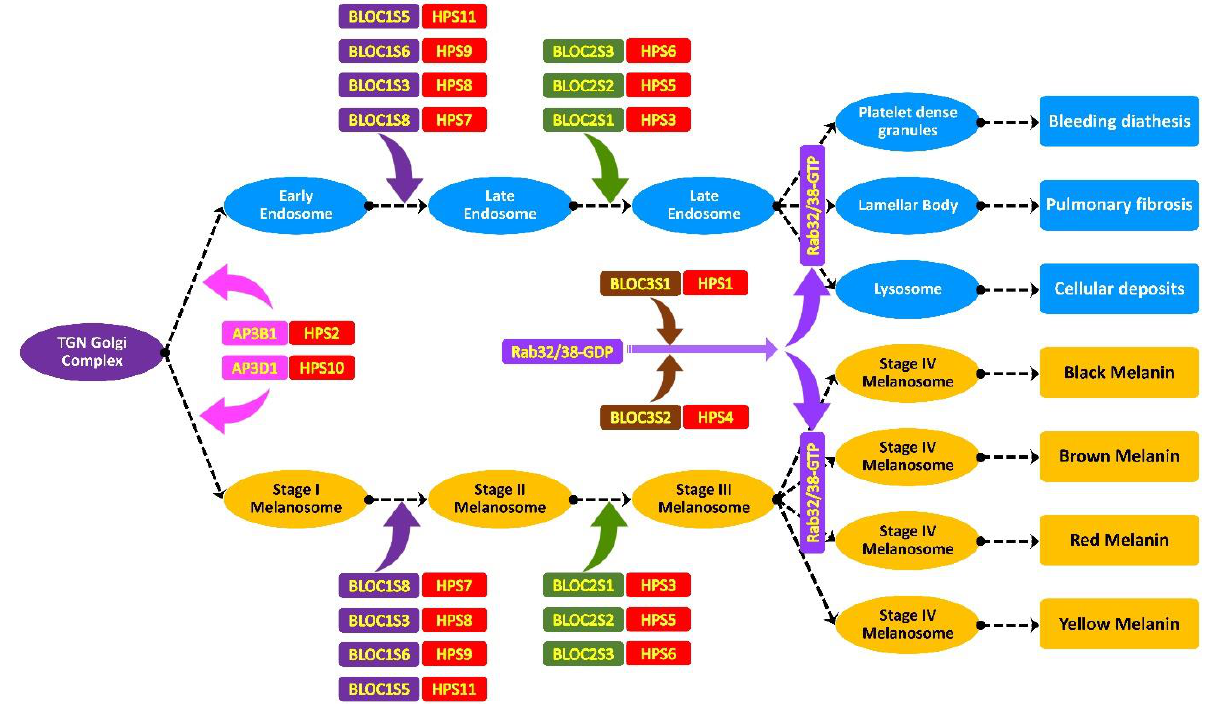
Figure 5. Endosomal pathway of TGN (trans-Golgi network) showing different stages of melanosome maturation, platelet δ -granule (dense granule), lamellar body and lysosome formation are shown. Protein complexes AP-3 (adaptor protein), BLOC-1 (biogenesis of lysosome-related organelles complex-1), BLOC-2 (biogenesis of lysosome-related organelles complex-2) and BLOC-3 (biogenesis of lysosome-related organelles complex-3) are shown. Any mutation in these complexes or in their subunits result in a different class of Hermansky – Pudlak syndrome.